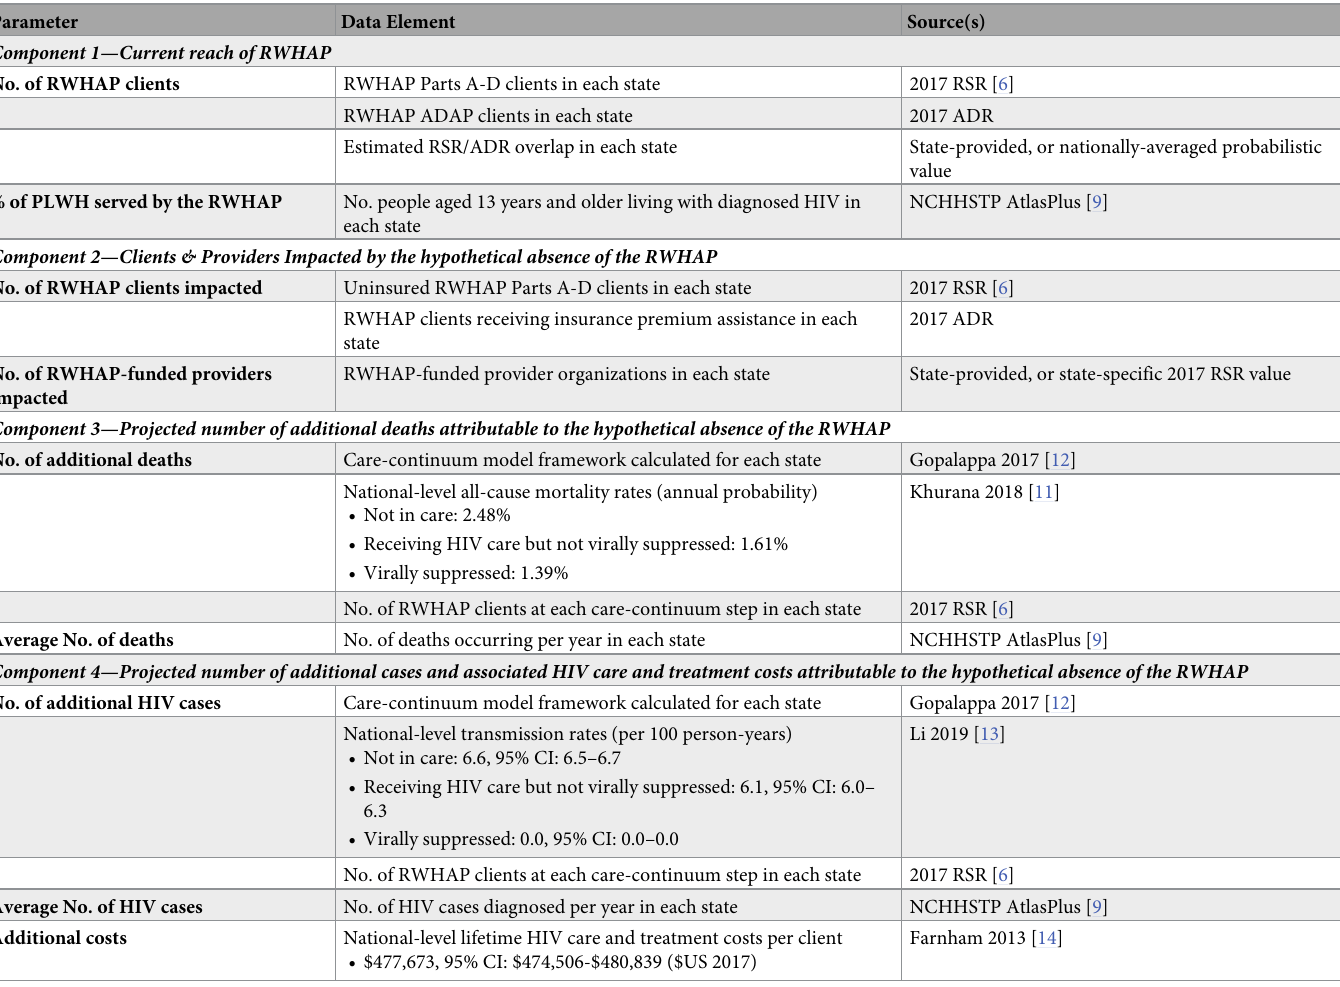
Table 1. Model parameters, underlying data elements, and data